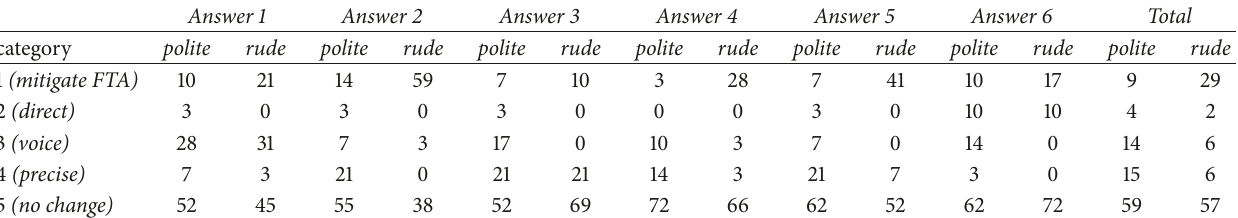
Table 3: Change suggestions for each of the five categories from participants for each of the six SDS answers according to conditions (polite versus rude), reported in